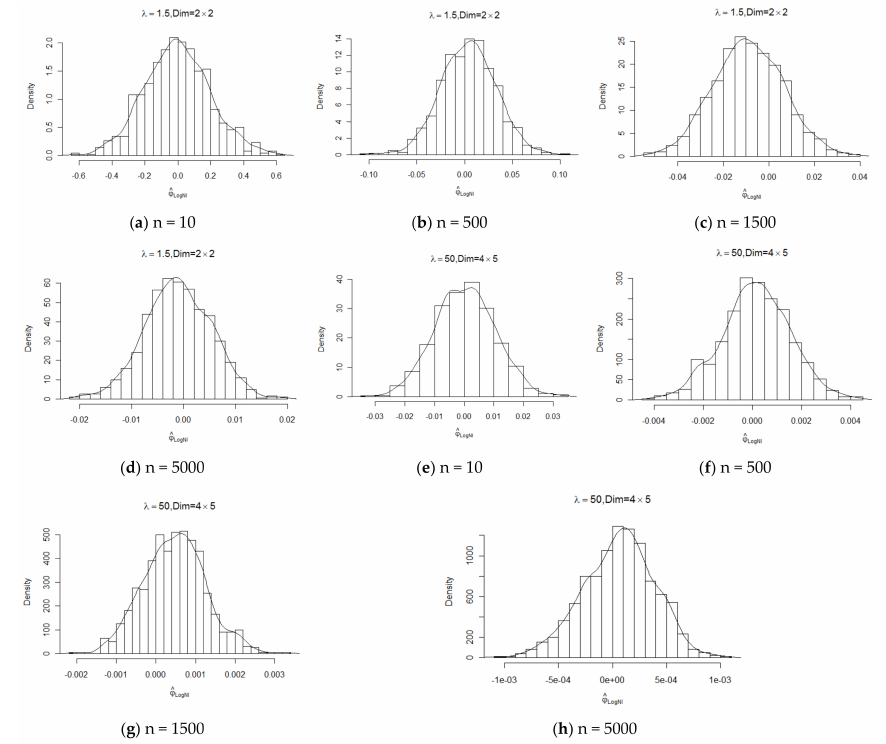
Figure 1. Sampling distribution of ˆ ϕ LogNI for various λ and n.